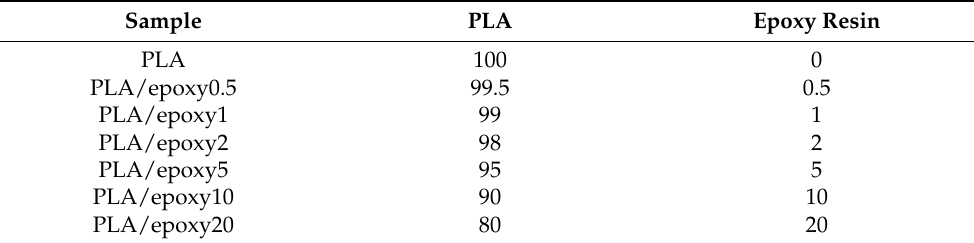
Table 1. Code name and composition of PLA and epoxy resin